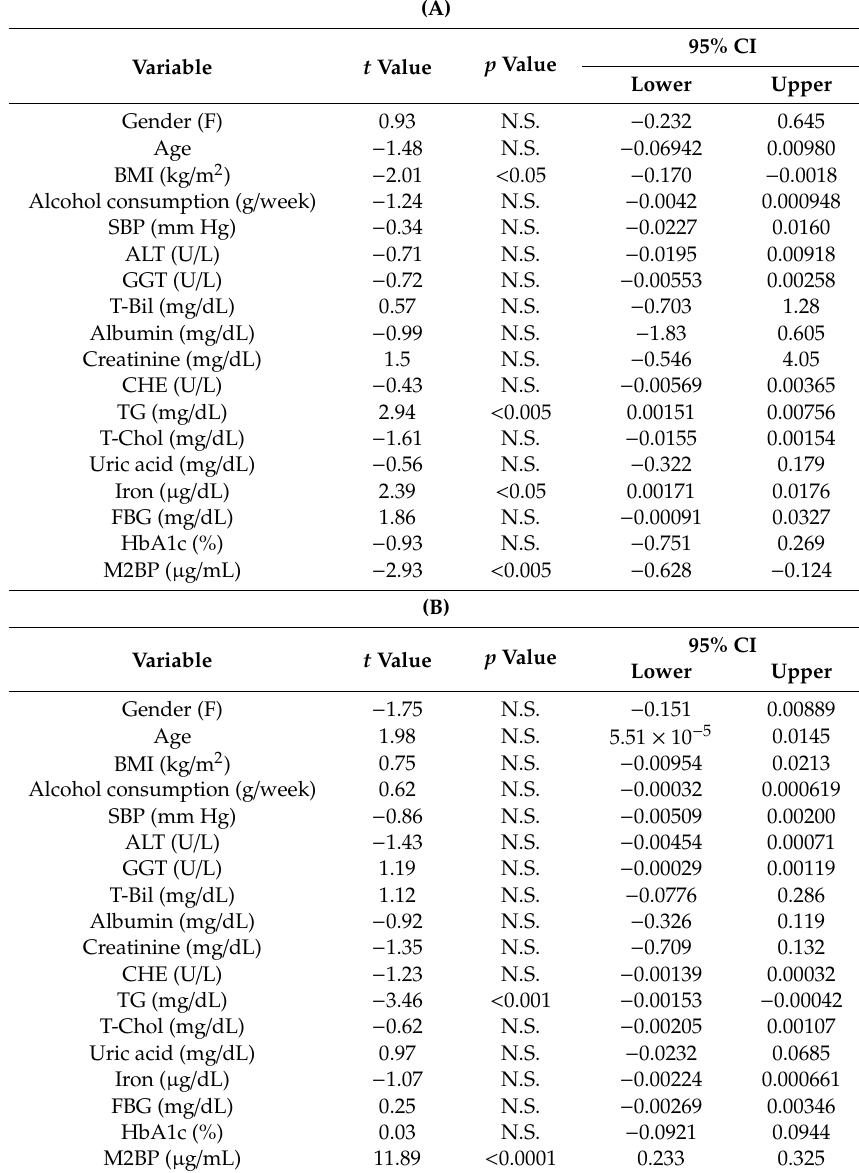
Table 6. M2BP could be a predictive biomarker for liver fibrosis progression. ( A ) Multivariate analysis of predicted changes in platelet count using baseline various variables. ( B ) Multivariate analysis of predicted changes in FIB4-index using baseline various